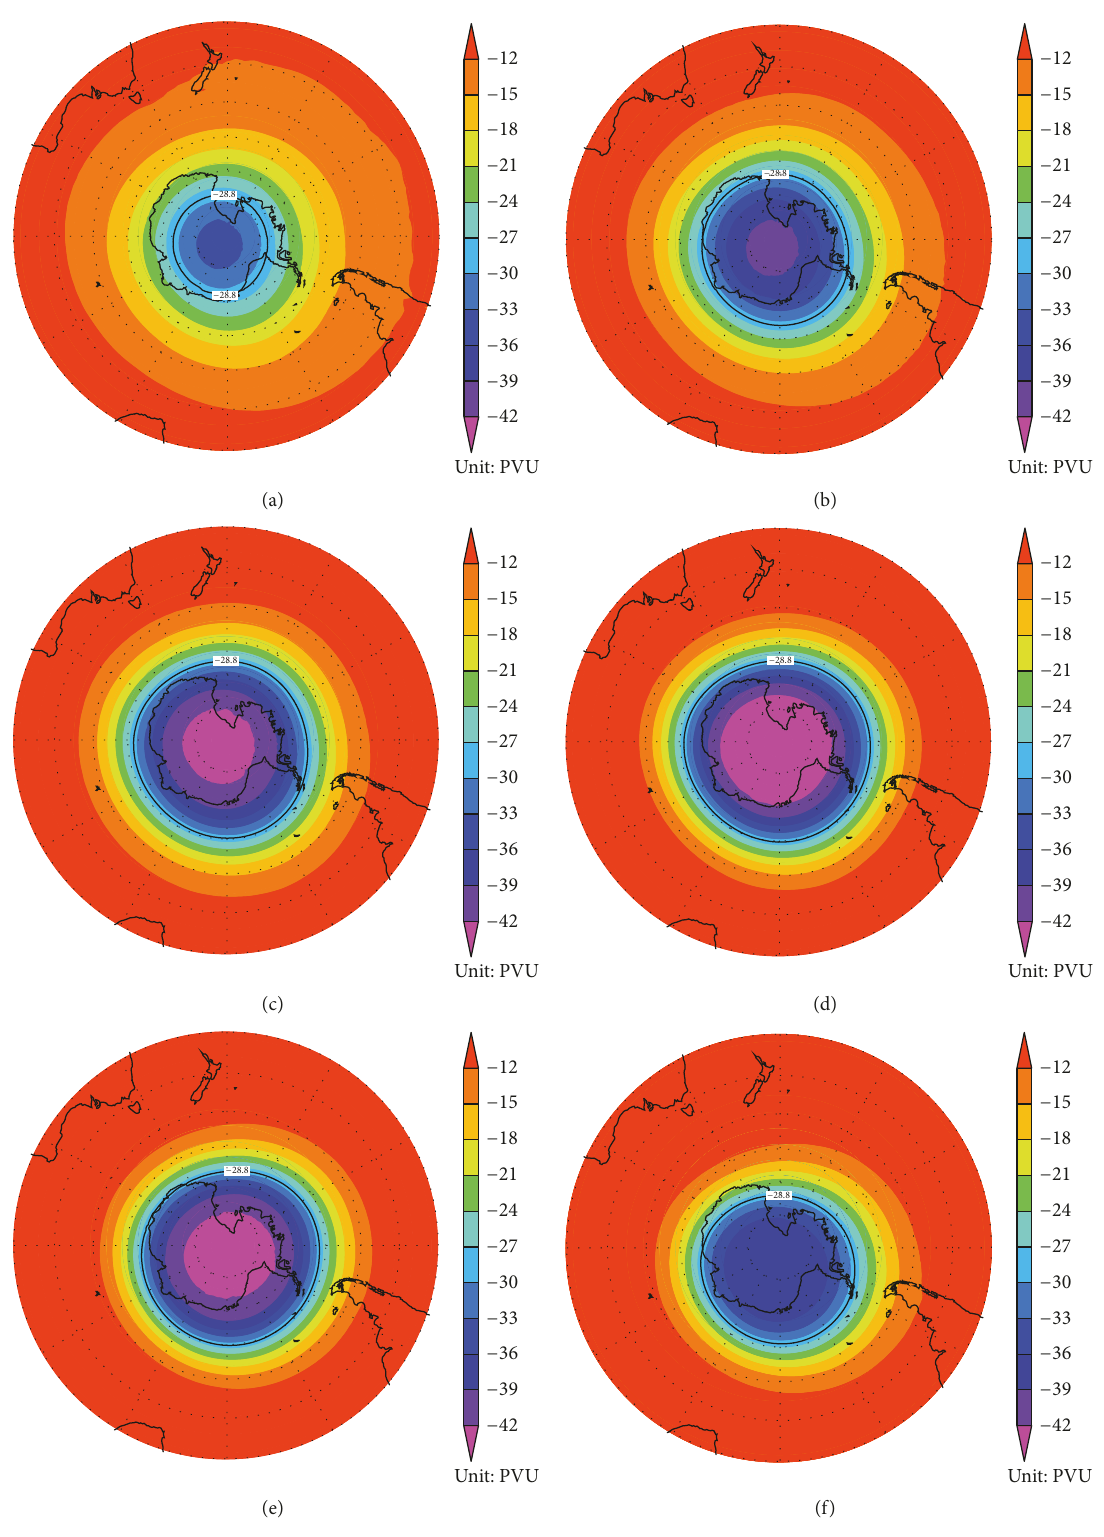
Figure 1: Spatial distributions of the 38-year (1979–2016) potential vorticity (units: PVU) climatology on 550 K isentropic surface in (a) May, (b) June, (c) July, (d) August, (e) September, and (f) October. The black solid based on criterion PV contour ( − 28.8 PVU) represents the vortex